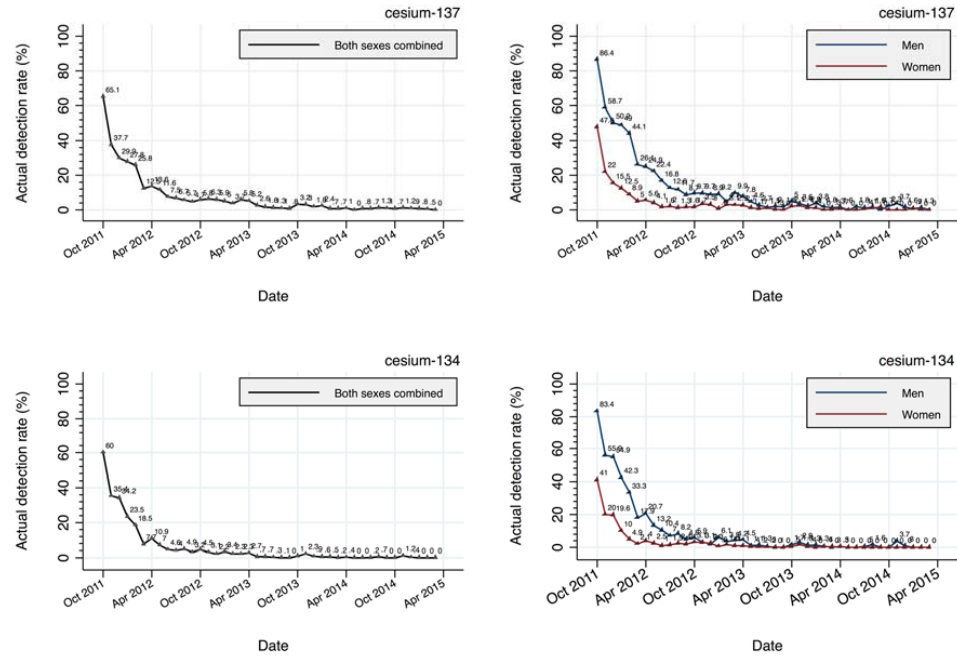
Figure 3. Monthly actual detection rates in both sexes combined (left ) and in men and women ( right ) for Cs-137 ( upper ) and Cs-134 ( lower ) in the WBC